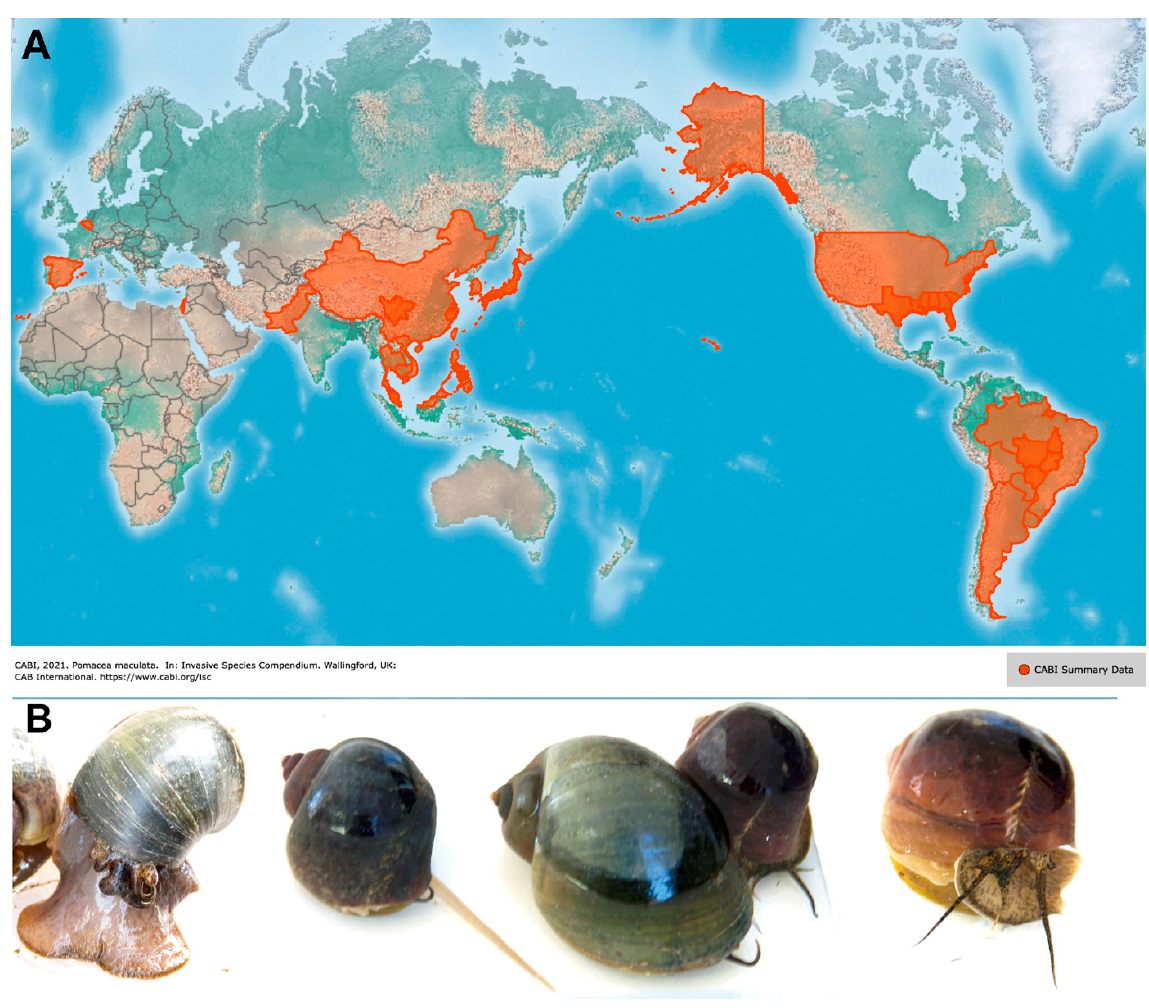
Figure 1. ( A ): P. maculata world distribution. Reproduced with permission from CABI 2021 [8] ( B ): Different images of P. maculata specimens used in the experiments.